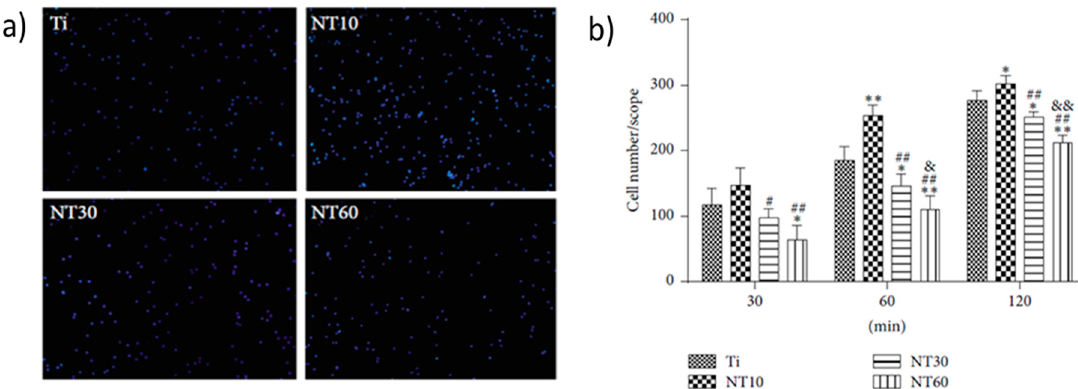
Figure 6. Fluorescence images of initial adherent bone marrow mesenchymal stem cells (BMSCs) stained with DAPI after 1 h ( a ) and cell numbers measured by counting cells for 0.5 h, 1 h, and 2 h ( b ). Cell attachment on NT10 (titanium nanotube with 10 nm diameter) was significantly improved compared with control Ti surfaces for 1 h and 2 h. In contrast, cell attachment was inhibited on NT30 (titanium nanotube with 30 nm diameter) and NT60 (titanium nanotube with 60 nm diameter) at each time interval adopted in this study. Reproduced with permission from [124].